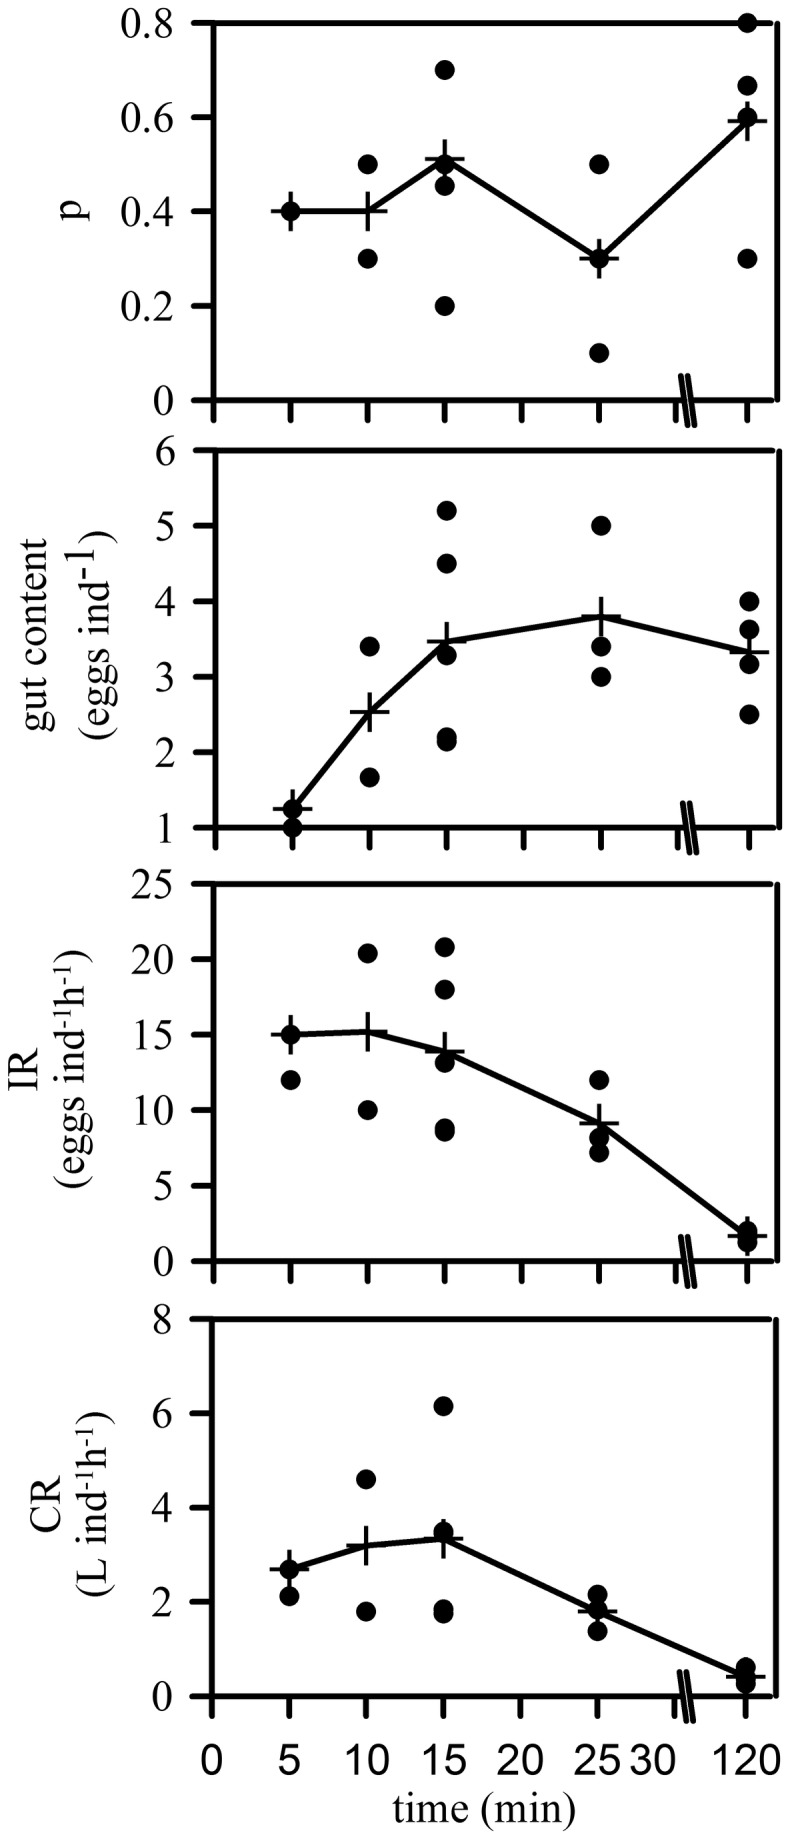
Effect of incubation time on the proportion of feeding ephyrae (p), the number of eggs inside the gastric pouches after incubation, the ingestion rate (IR) and the Clearance Rate (CR).Dots are observations (beakers), and crosses represent means for each incubation time. Crosses have been joined by lines to visualize tendencies.